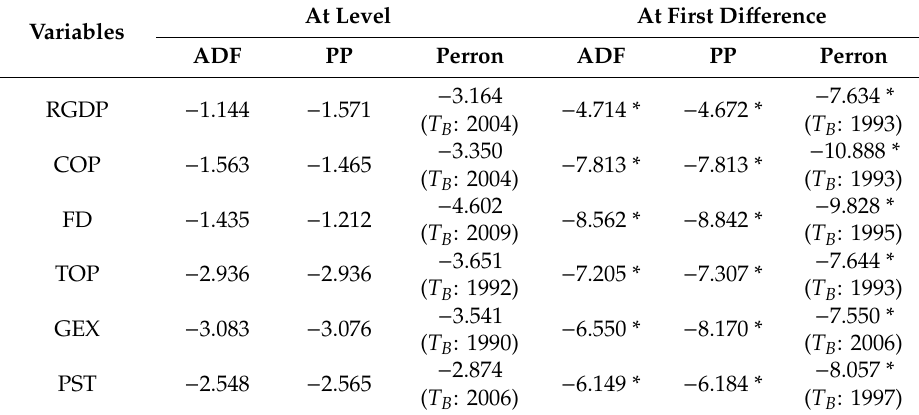
Table 4. The unit root test results.